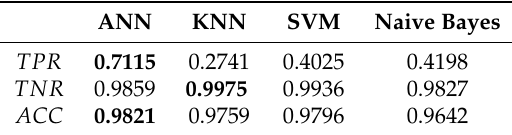
Table 6. Classification accuracy for different algorithms before the training set is balanced. ANN: artificial neural network; KNN: k-nearest neighbors; SVM: support vector machine; TPR: true positive rate; TNR: true negative rate; ACC: classification